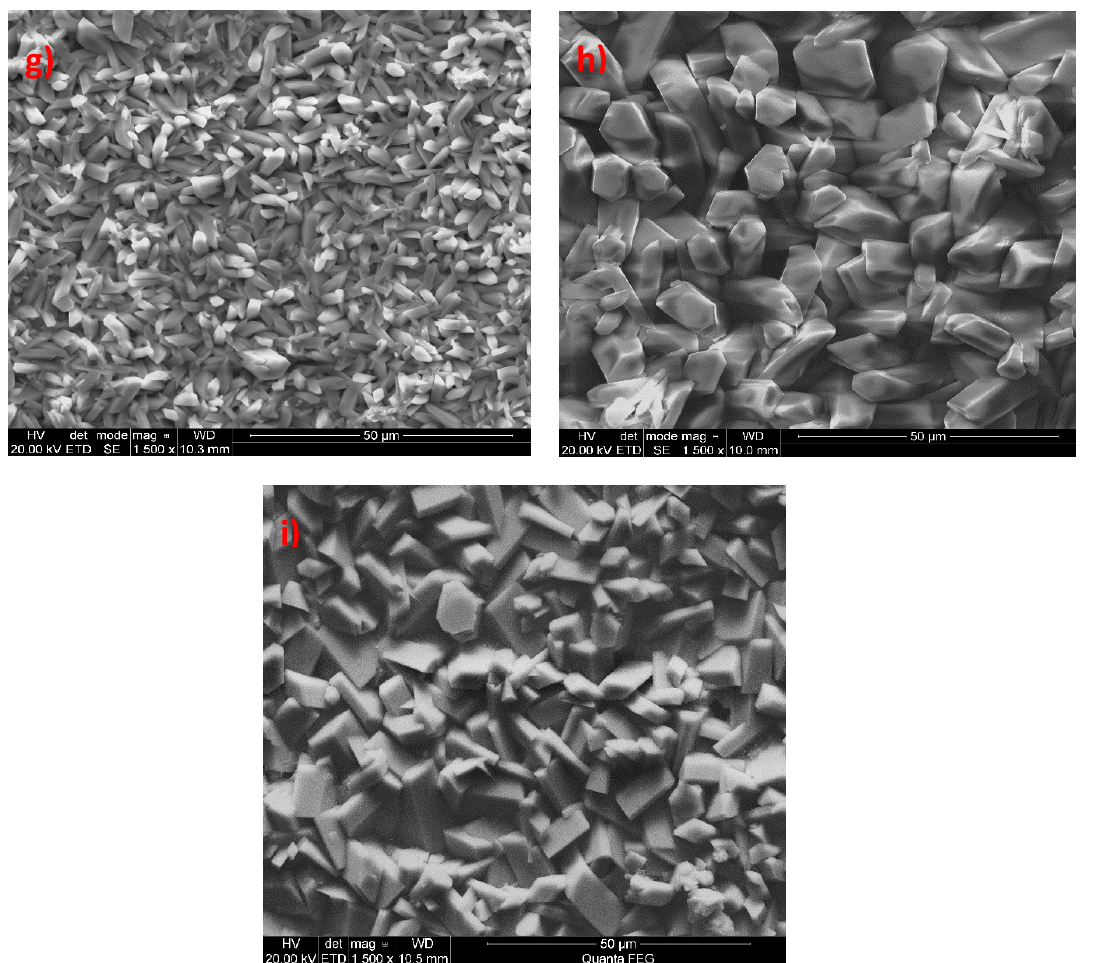
Figure 2. SEM image of the manganese phosphate coating: ( a ) modified with: Na 2 MoO 4, 1500 × magnification ( b ), CaCO 3 , 1500 × magnification ( c ), Sr(NO 3 ) 2 , 5000 × magnification ( d ), ZnO, 5000 ×